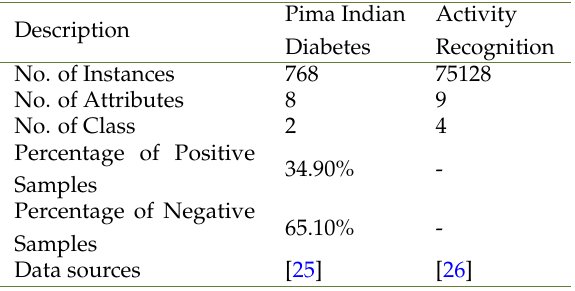
Table 1. Dataset